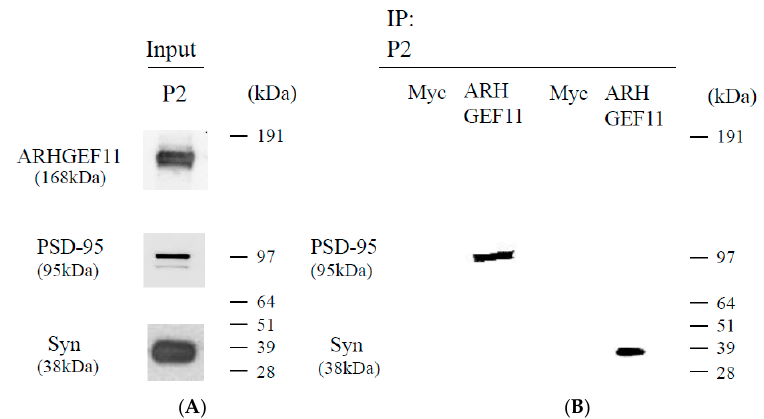
Figure 2. Formation of ARHGEF11 and synaptic marker protein complex. The immunoprecipitation of synaptophysin and PSD-95 with ARHGEF11 (Acris) or negative control (Myc antibody): input ( A ); and immunoprecipitation ( B ). ARHGEF11 was coimmunoprecipitated with synaptophysin (38 kDa) and PSD-95 (95 kDa) in P2 fractions ( B ). Three independent experiments were conducted.